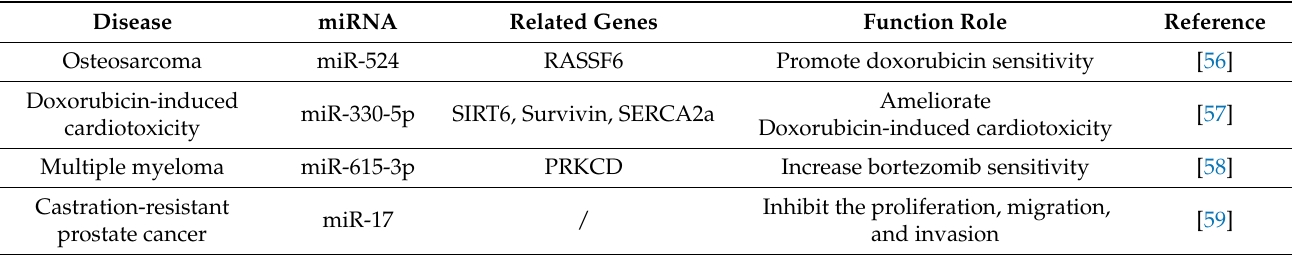
Table 4. Target and role of circ-ITCH in drug resistance/toxicity.